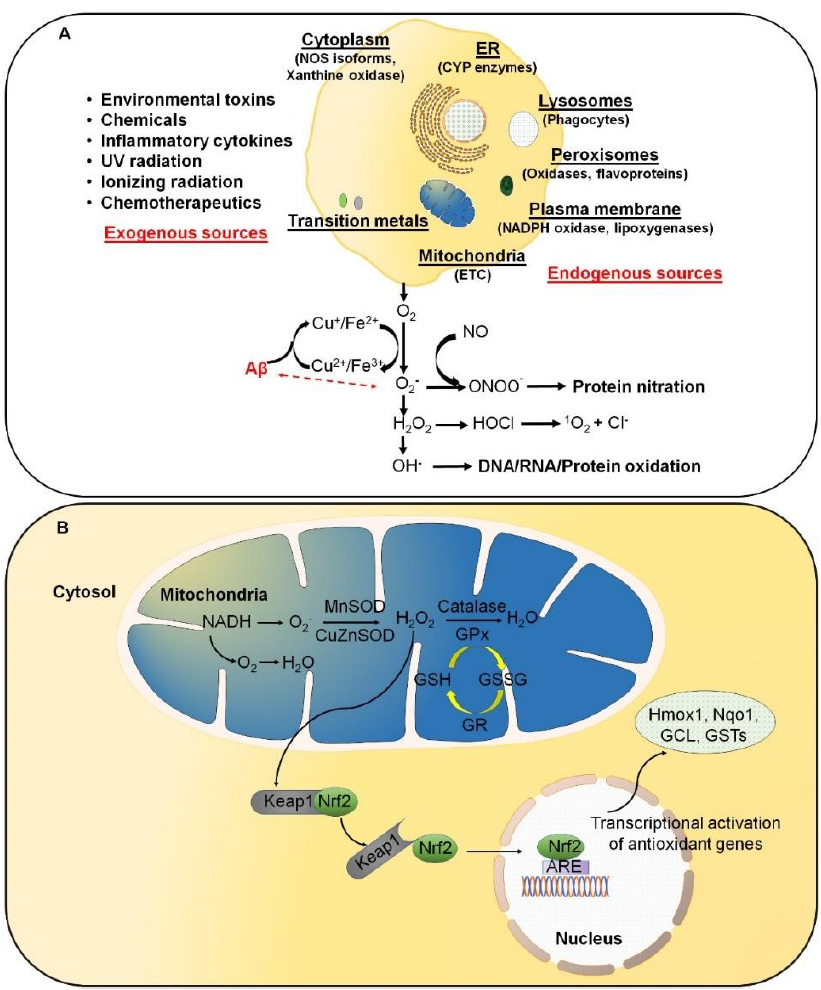
Figure 1. Excessive reactive oxygen species (ROS) are likely involved in the initiation and/or amplification of oxidative stress during the onset and progression of Alzheimer’s disease (AD). ( A ) ROS can be produced from both endogenous and exogenous sources. The endogenous sources of ROS include different cellular organelles, such as mitochondria, peroxisomes, and the endoplasmic reticulum, where oxygen consumption is high. ( B ) Under physiological conditions, a cellular balance is established between ROS generation and clearance, and is maintained by several antioxidative defense mechanisms.